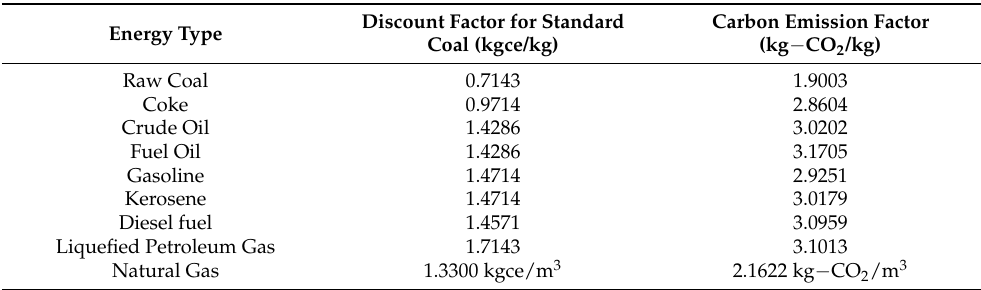
Table 1. Conversion coefficient of standard coal and carbon emission coefficient of various energy